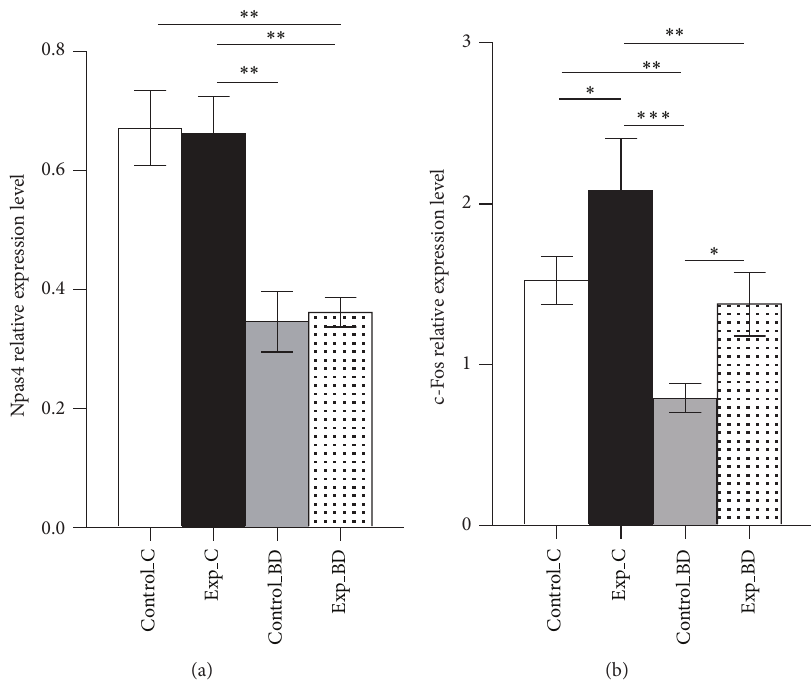
Figure 3: (a) Npas4 expression in spared C rows and in deprived regions (averaged rows B and D). Control C: spared row C on control side (deprived for 24 hours); Exp C: spared row C on experimental side (deprived 7 days); Control BD: deprived B and D rows on control side; Exp BD: deprived B and D rows on experimental side; mean ± SEM ∗∗ 𝑃 < 0.01 . Duration of deprivation had no impact on Npas4 expression. (b) In deprived B and D rows deprivation lasting 7 days induced increase in c-Fos expression; mean ± SEM ∗ 𝑃 < 0.05 ; ∗∗ 𝑃 < 0.01 ; ∗∗∗ 𝑃 < 0.001 .